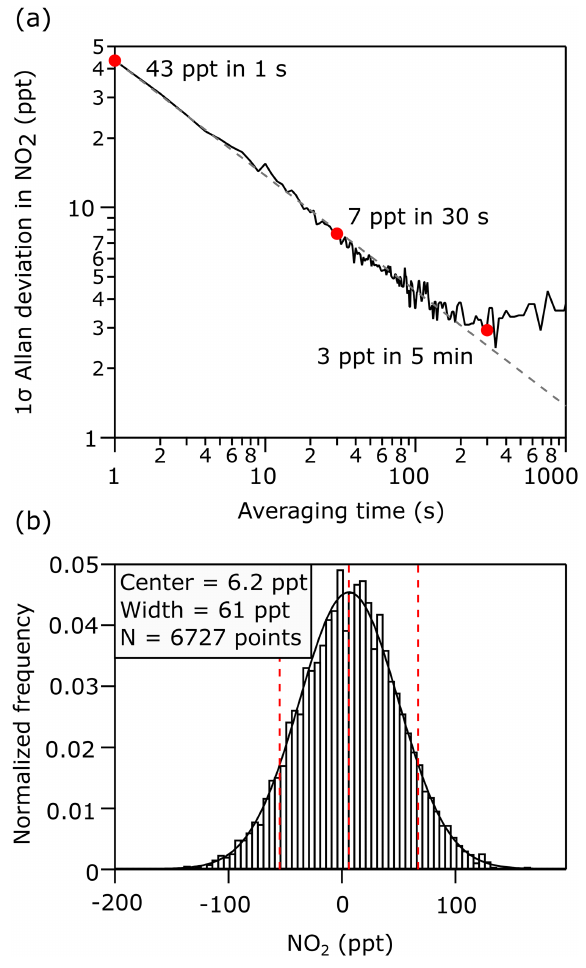
Figure 3. (a) Allan deviation plot of the retrieved NO 2 concentra- tion during zero air addition to the cavity. (b) Normalized frequency distribution of the retrieved NO 2 concentration during the same zero air measurement time period.